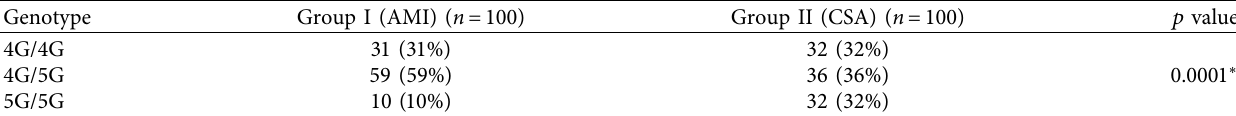
Table 5: Genotypic distribution of 4G/5G polymorphism for AMI and CSA cases. Genotype